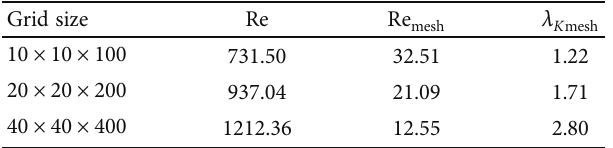
Figure 7: Plot of the interface area divided by the mixingzonevolume vs. time. Both the area and the volume are measured in mesh units ( thequantity ½ physicalarea/physicalvolume  × Δ x isplotted ). Results for three mesh levels are displayed for a 3D single-mode RT instability. t = 11 : 0 for several Table 1: Table relating Re and λ K to Re mesh at mesh levels. Kolmogorov scale λ K = λ K / Δ x . Schmidt number S mesh c = 5 : 2